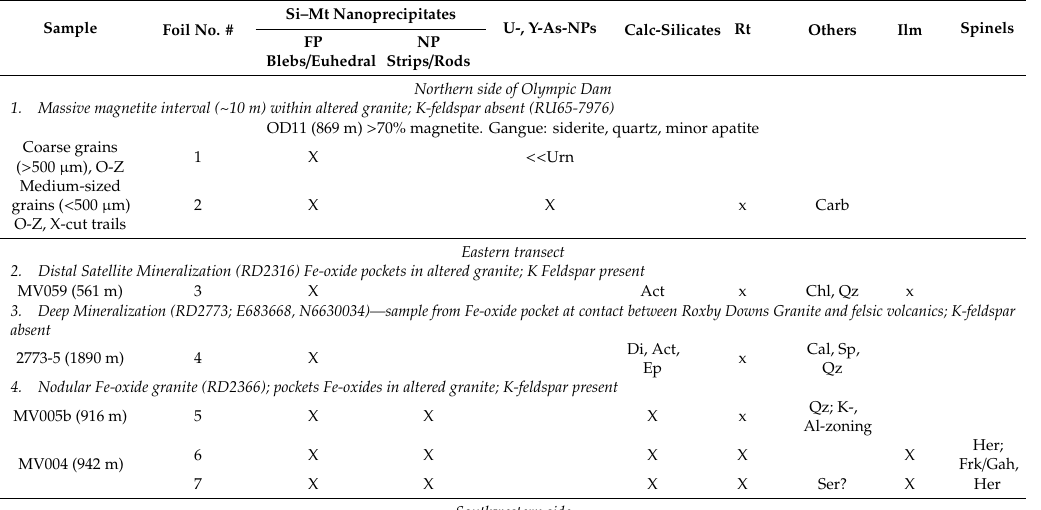
Table 2. Overview of